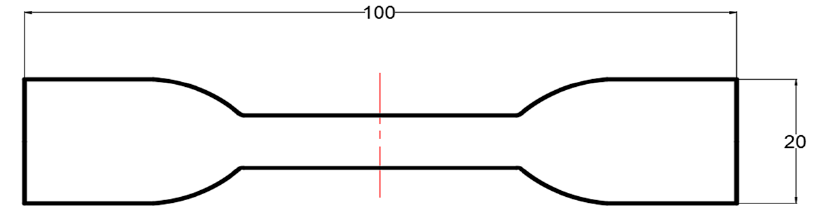
Figure 3. The dumbbell-shaped specimens.